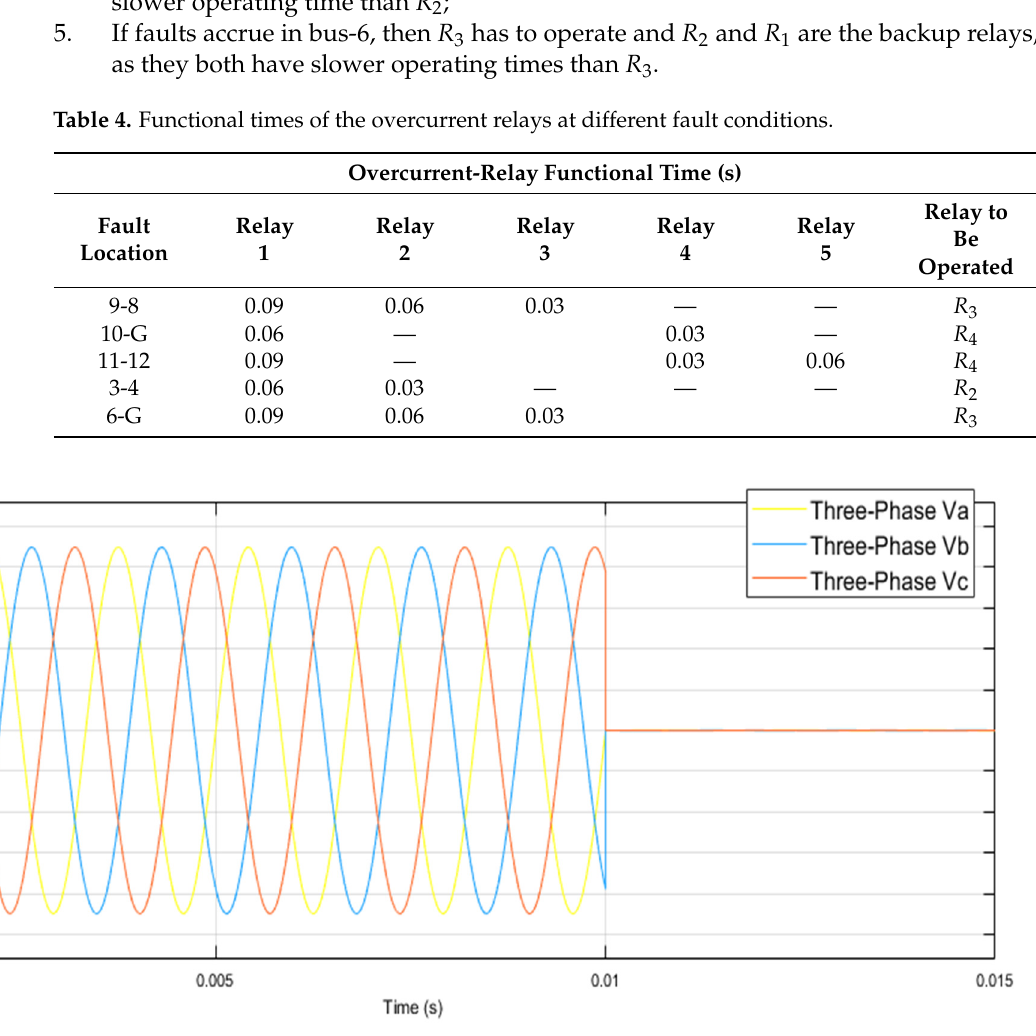
Figure 9. Three-phase voltage waveforms that ensure that the fault has been detected after 0.01 s.